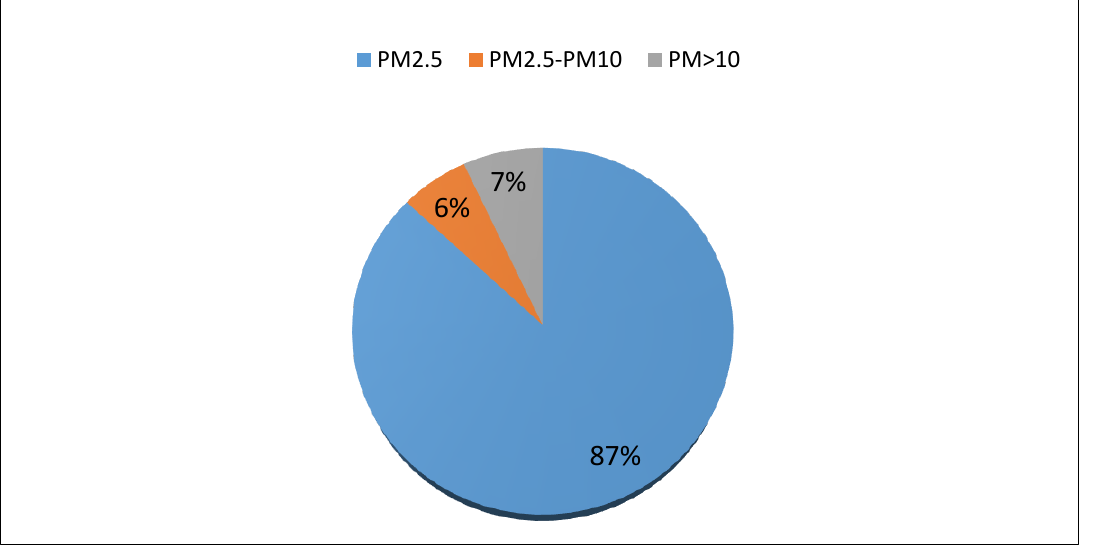
Figure 4. PM 2.5 , PM 2.5–10 and PM >10 amounts in the TSP produced by a modern SWI [20].